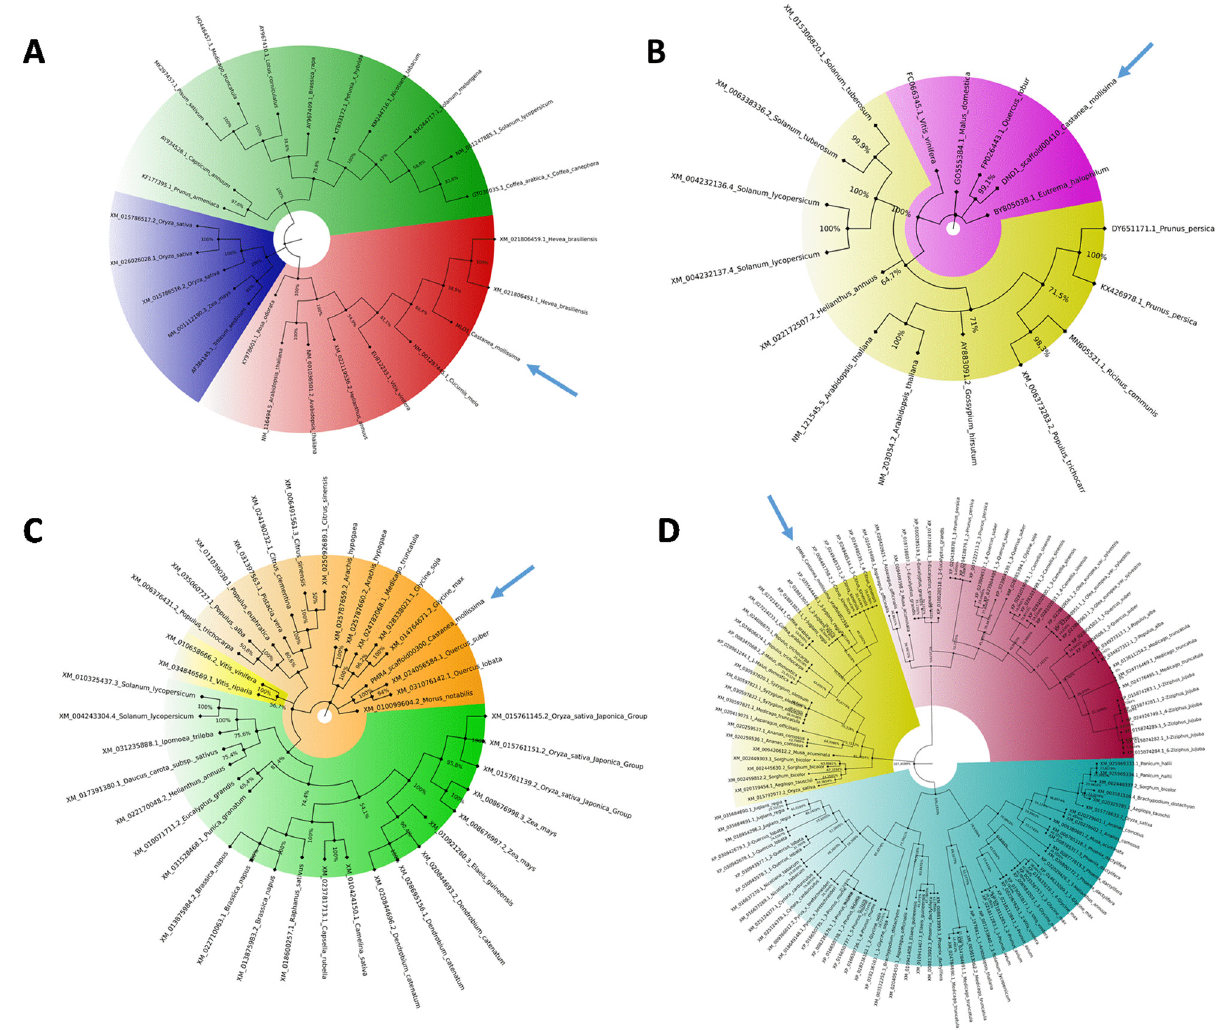
Figure 2. Phylogenetic analysis of the S-genes. The 4 phylogenetic trees of mlo1 ( A ), dnd1 ( B ), pmr4 ( C ), and dmr6 ( D ) were constructed using MEGAX software by aligning chestnut S-gene coding sequences with NCBI S-gene ortholog coding sequences (available in S3 File). The colors indicate the main clades detected, and the arrows underline the location of C. mollissima . To visualize details, all the phylogenetic trees are available in S4 File.